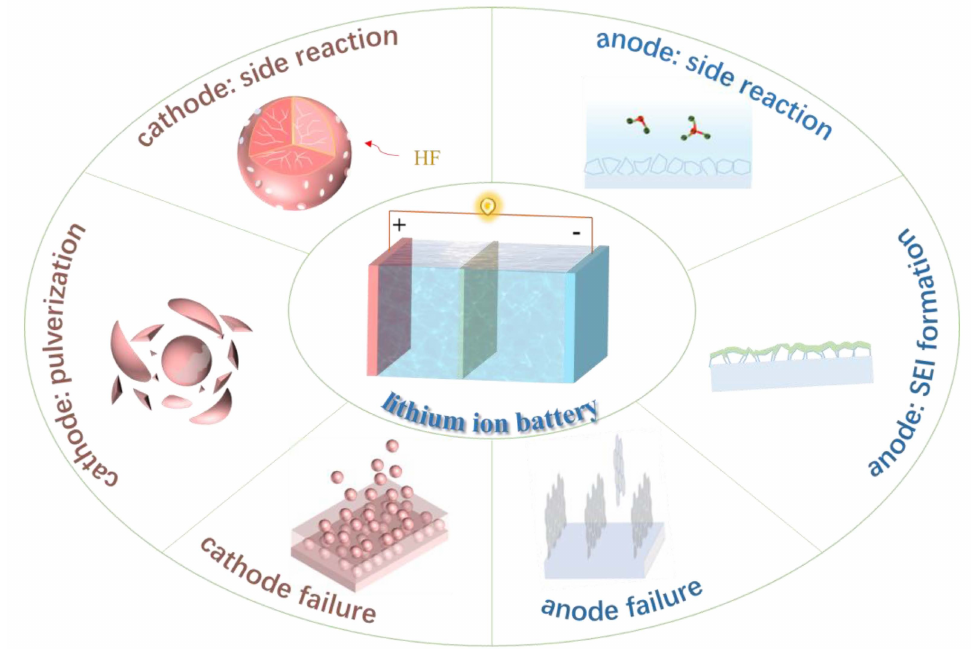
Figure 3. Schematic illustration of issues at the interface of electrode/electrolyte in lithium-ion